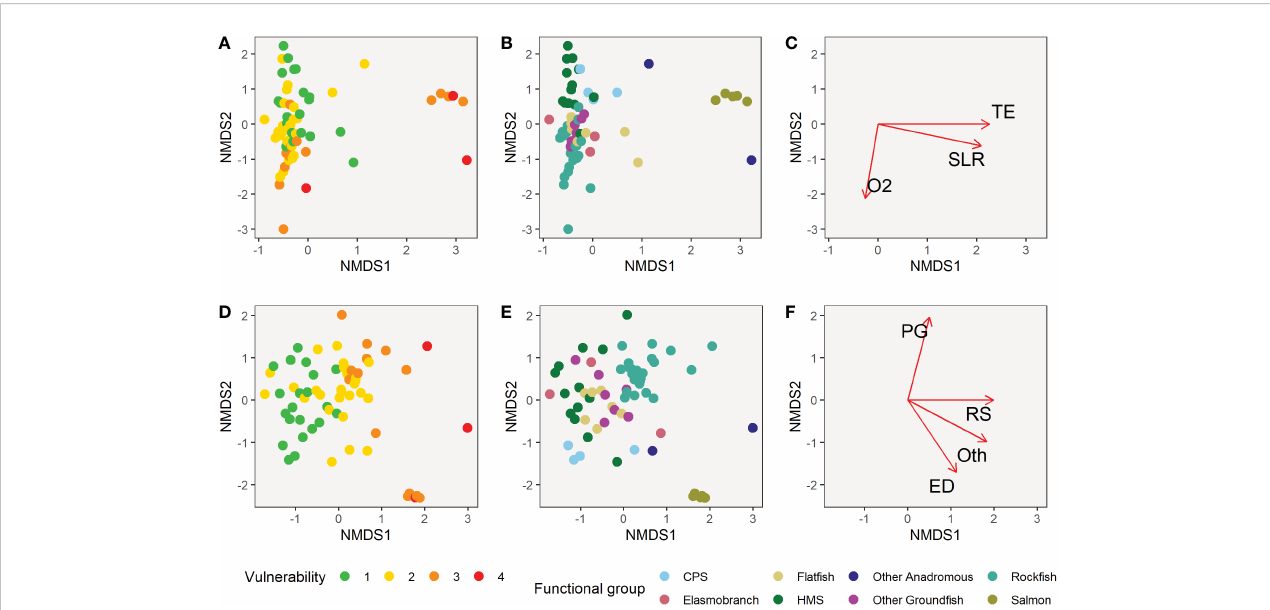
FIGURE 6 Non-metric multidimensional scaling (NMDS) plots showing the position of each of the 64 species relative to the two NMDS axes for climate exposure (A – C) and biological sensitivity (D – F) . Panels (A) and (D) are color-coded by the species vulnerability scores, showing association between vulnerability and NMDS axis scores. Panels (B) and (E) are color-coded by functional group, showing that these groups tend to cluster along the NMDS axes. The correlation between the climate factors and the NMDS axes are represented by the length of the arrows in panel (C) and the correlation between the biological sensitivity attributes and the NMDS axes are represented by the length of the arrows in panel (F) . Only factors with signi fi cant correlations with either NMDS axis are displayed these panels. Abbreviations for strongly correlated factors include population growth rate (PG), reproductive strategy (RS), early life history dispersal (ED), other (Oth), air temperature (TE), sea level rise (SLR), dissolved oxygen